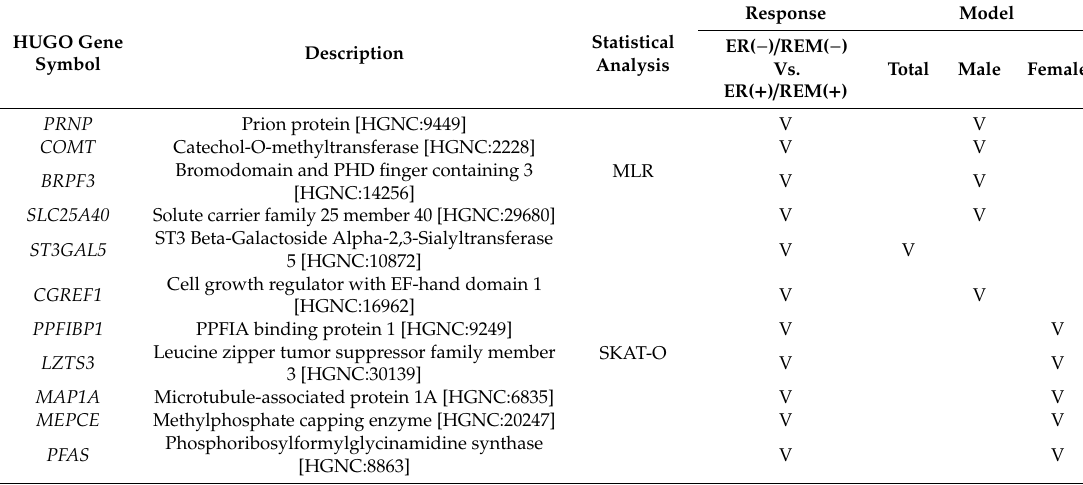
Table 1. Summary of analysis